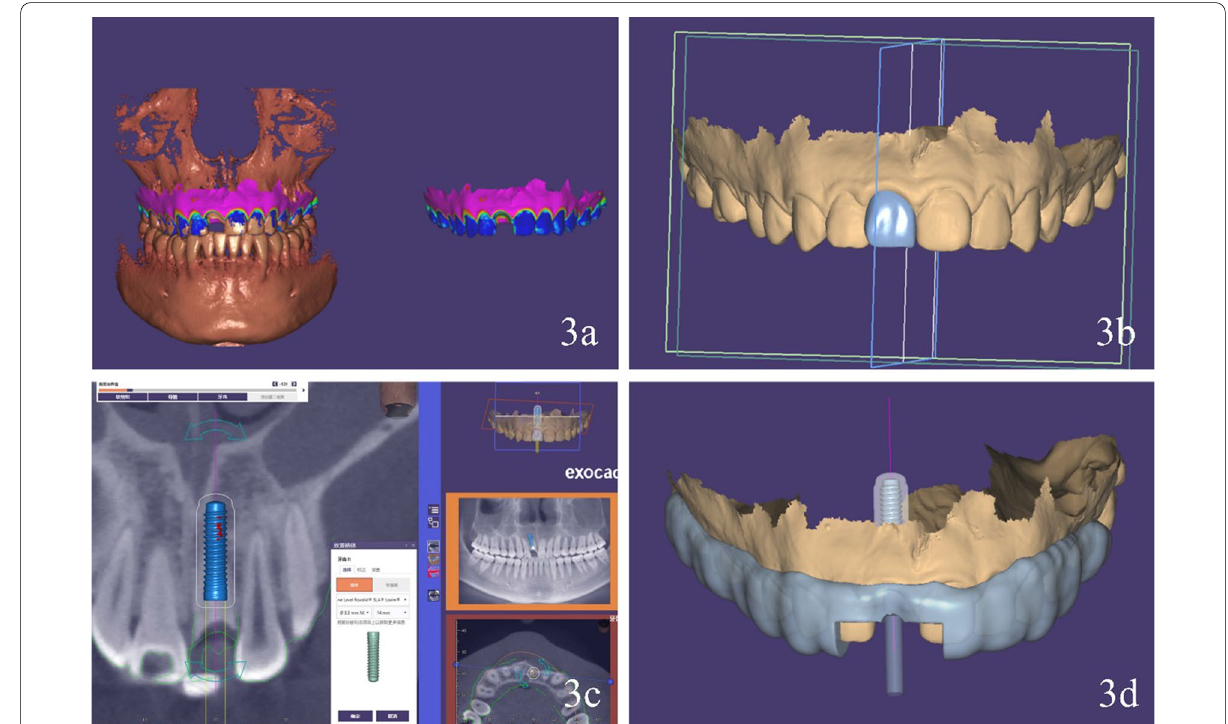
Fig. 3 Digital surgical guide design. a Intraoral scan and CBCT scan superimposed. b Design of diagnostic virtual interim restoration. c Placement of virtual implant. d Completed surgical guide. CBCT cone beam computed